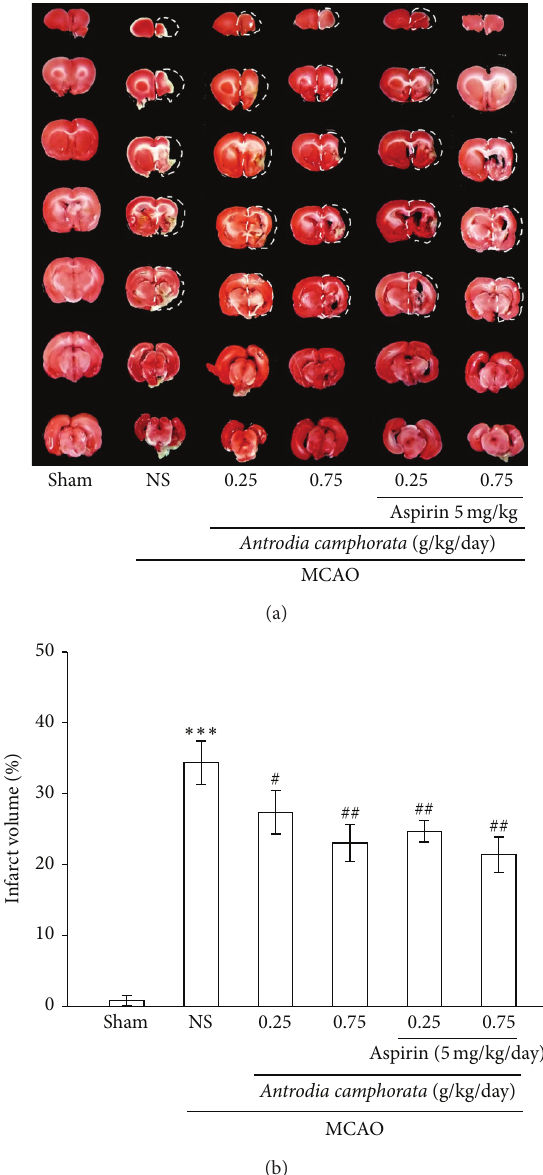
Figure 1: (a) Combination treatment of the extract of A. camphorata withaspirinagainstthromboembolicstrokeinrats.Coronalsections of 2,3,5-triphenyltetrazolium- (TTC-) stained brains after throm- boembolic occlusion-reperfusion rats were observed in a sham- operated group (sham), a group orally treated with an isovolumetric solvent (distilled water) for 60 days, followed by thromboembolic occlusion (MCAO group), groups orally treated with A. camphorata for 60 days alone, followed by thromboembolic occlusion, and groups orally treated with A. camphorata (0.25 and 0.75 g/kg/day) combined with aspirin (5mg/kg/day) for 60 days, followed by thromboembolic occlusion as described in “Section 2.” The results are representative examples of three similar experiments; (b) den- sitometric analysis of the combination treatment of the extract of A. camphorata with aspirin against thromboembolic stroke in rats. Dataarepresentedastheinfarctvolumeforeachanimalinthegroup as well as the means ± S.E.M. ( 𝑛 = 5 ). ∗∗∗ 𝑃 < 0.001 compared to the sham-operated group, # 𝑃 < 0.05 and ## 𝑃 < 0.01 compared to the MCAO